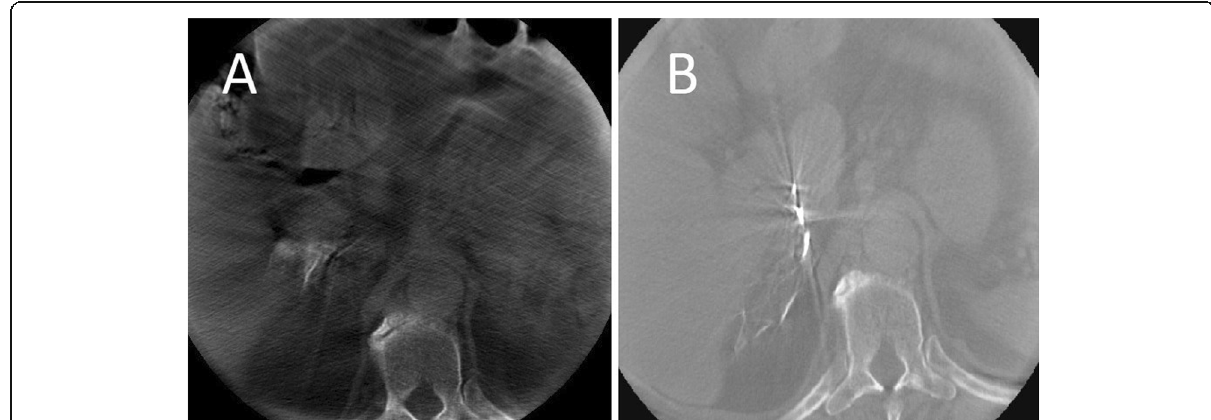
Fig. 2 Cone-beam CT of an accessory hepatic vein ( a ) and the right adrenal vein ( b ). In this patient, two different veins were cannulated. Given